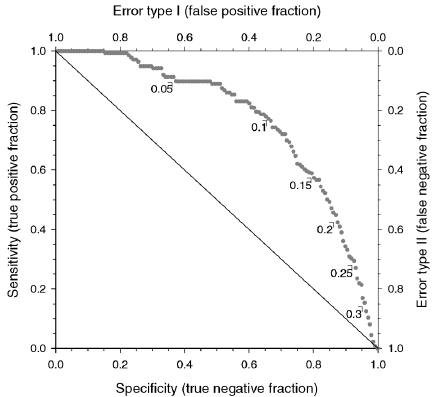
Figure 8. Example of a ROC plot. Graphic from Beguería